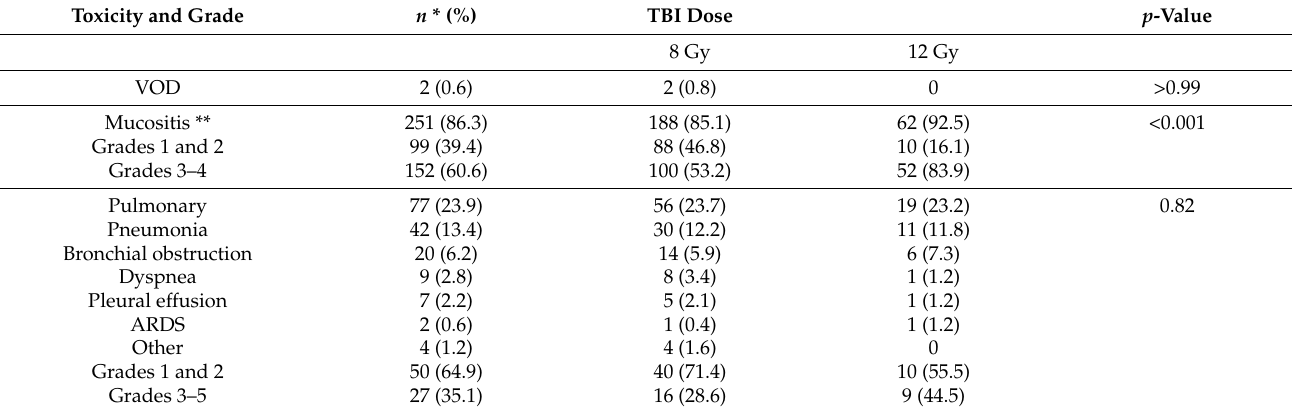
Table 2. Overview of toxicities regarding different organ systems and comparison between 8 and 12 Gray conditioning regimens (Fisher’s exact test). Multiple toxicities were possible for each patient. Percentage values of toxicities are given in parentheses and refer to the respective cohort ( n = 322 for the whole cohort, n = 236 for the 8 Gy group and n = 82 for the 12 Gy group) except for mucositis. Percentage values of toxicity grades show the distribution of toxicity grades according to Common Terminology Criteria for Adverse Events version 5.0 and add up to 100% in each category. ARDS: acute respiratory distress syndrome, Gy: Gray, TBI: total body irradiation, VOD: veno-occlusive disease. Toxicity and